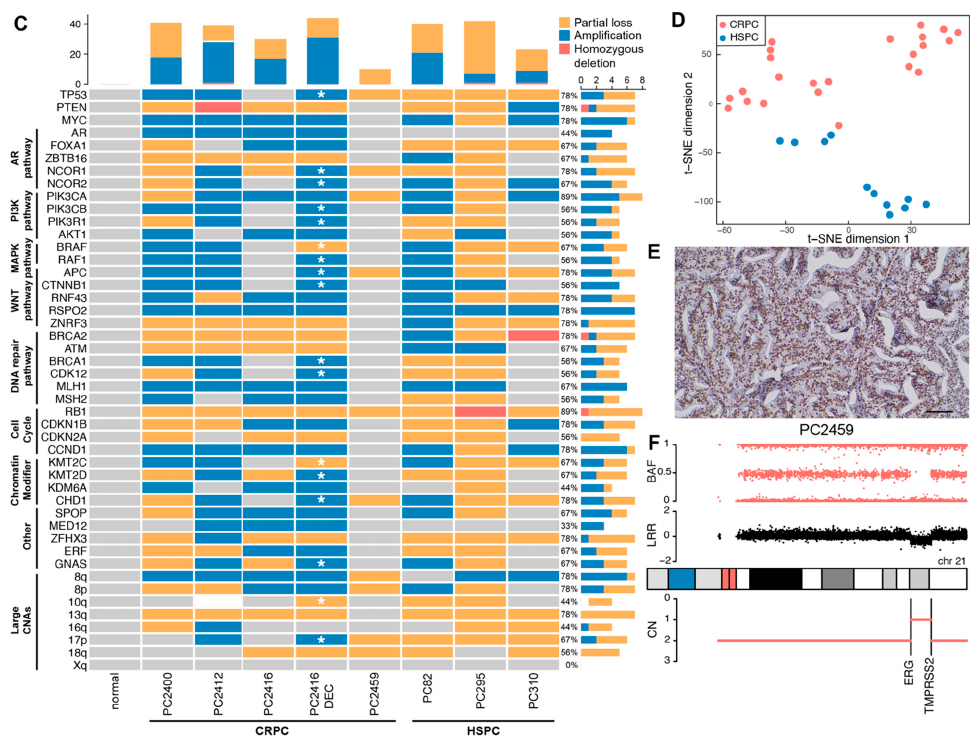
Figure 2. Characteristics of CRPC xenografts. ( A ) Growth trajectories of PDXs in the first 600 days after engraftment. Each step marks a mouse-to-mouse transplantation. Time from tumor engraftment to first mouse-to-mouse transplantation is indicated by an arrow. ( B ) Histological architecture of PDXs (top panel) and original patient tumors (bottom panel), examined by hematoxylin and eosin staining. Scale bars equal 100 µm. ( C ) CNA profiles of CRPC PDXs (PC2400, PC2412, PC2416, PC2416-DEC and PC2459), HSPC PDXs (PC82, PC295 and PC310) and a normal prostate tissue control from an unmatched source, across a subset of genes and genomic regions recurrently altered in CRPC. Grouping per biological pathway. Amplifications (blue), homozygous deletions (red), partial losses (yellow) and unaltered regions (grey) are indicated based on ASCAT analysis of SNP array data ( n = 1 for each PDX). ASCAT analysis failed for PC2412 PDX due to sample complexity. All PC2412 CNA calls were determined manually except for the region 10q with complex rearrangements (white). CNA frequency bar plots are provided for each PDX (top panel) and each genomic region (right panel). Additional alterations present in PC2416-DEC PDX, as compared to PC2416 PDX are marked with a white asterisk. ( D ) t -SNE plot of pathway activity in CRPC PDXs (PC2400 ( n = 5), PC2412 ( n = 5), PC2416 ( n = 5), PC2416-DEC ( n = 5) and PC2459 ( n = 3); red) and HSPC PDXs (PC82 ( n = 2), PC295 ( n = 2), PC310 ( n = 7); blue), based on GSVA scores for 50 MSigDB cancer hallmark gene sets, using RNA sequencing data. ( E ) Nuclear ERG staining in PC2459 PDX. Scale bar indicates 100 µ m. ( F ) Copy number profile of chromosome 21 in PC2459 PDX, displaying the ERG and TMPRSS2 genes on 21q22.2-3. BAF: B allele frequency; LRR: log R ratio; CN: total copy